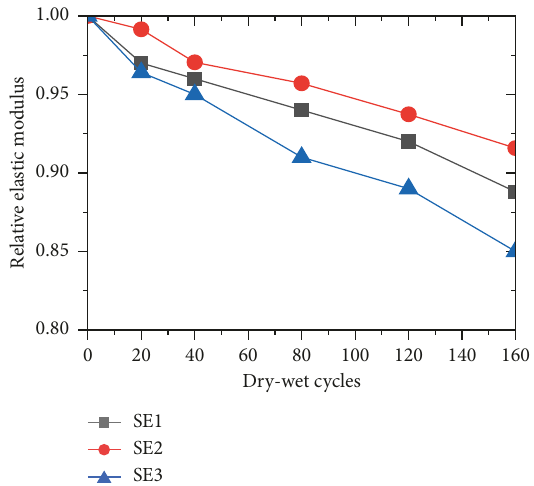
Figure 9: The relationship between relative elastic modulus and dry-wet